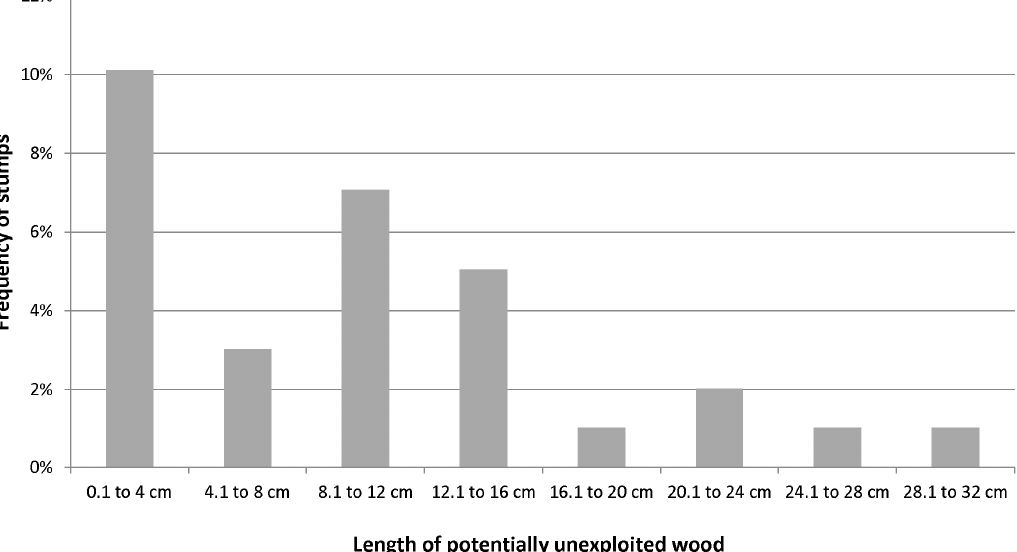
Figure 11. The frequency of stumps presented in classes referring to the length of potentially exploited wood derived by the 10%-quantile wood derived by the 10%-quantile analysis.